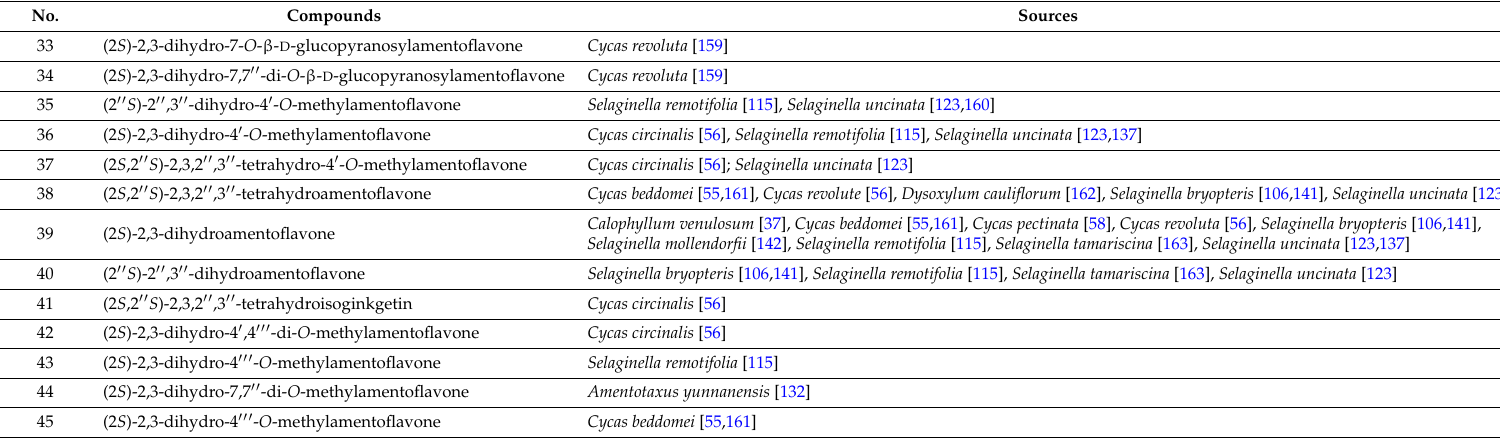
Table 3. Hydrogenation derivatives of